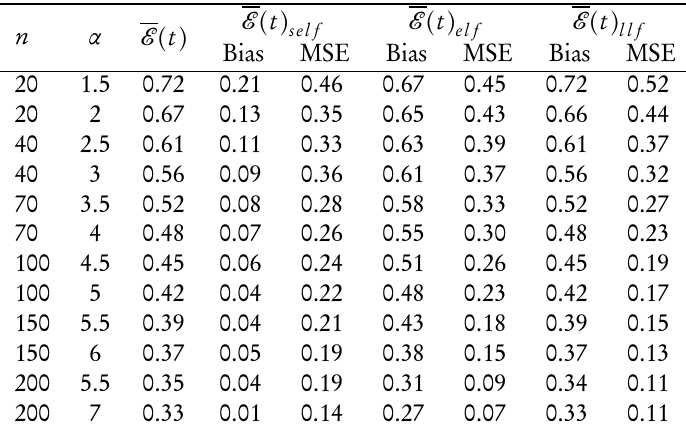
The bias and MSE of important sampling procedure for Bayes estimators of (cid:69) ( t ) using c = 1 and h = 1 .